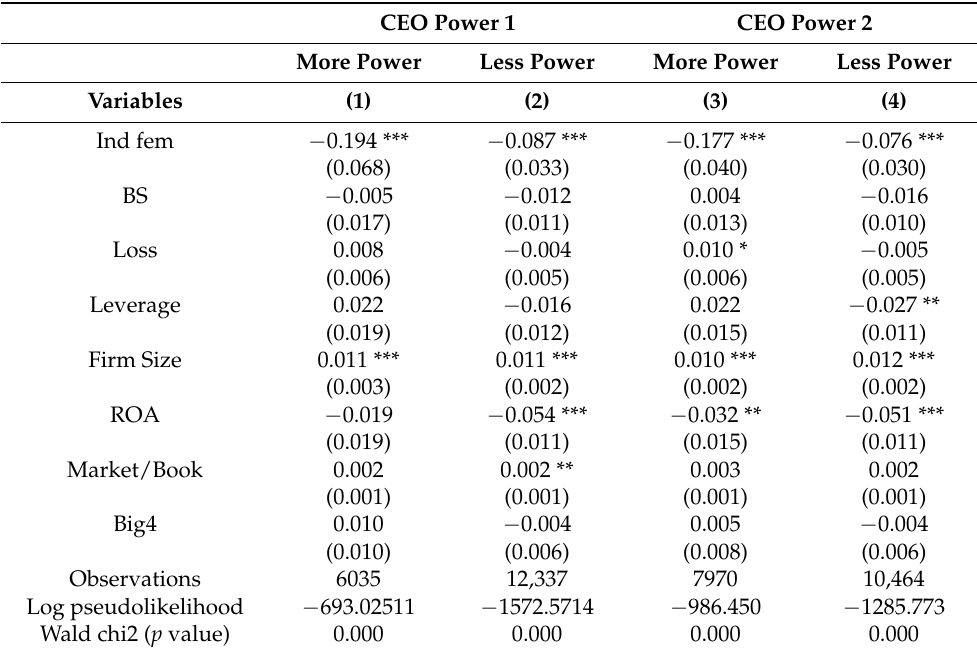
Table 8. Independent female directors and fraud: Subsamples according to CEO power—i.e., more power vs. less power (marginal